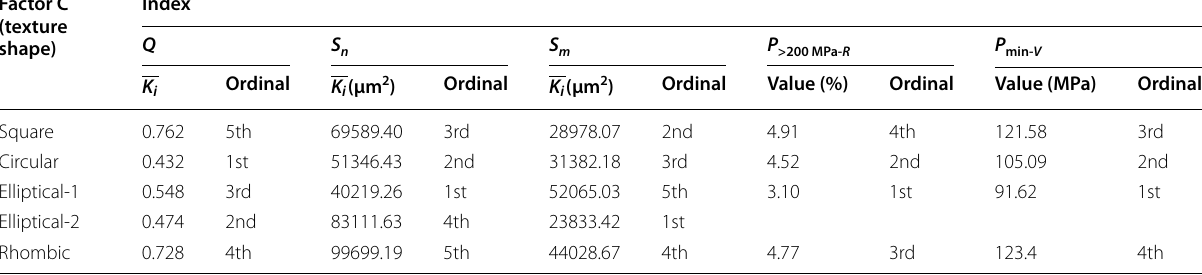
The mean values K i of Q come from the data of Table 3